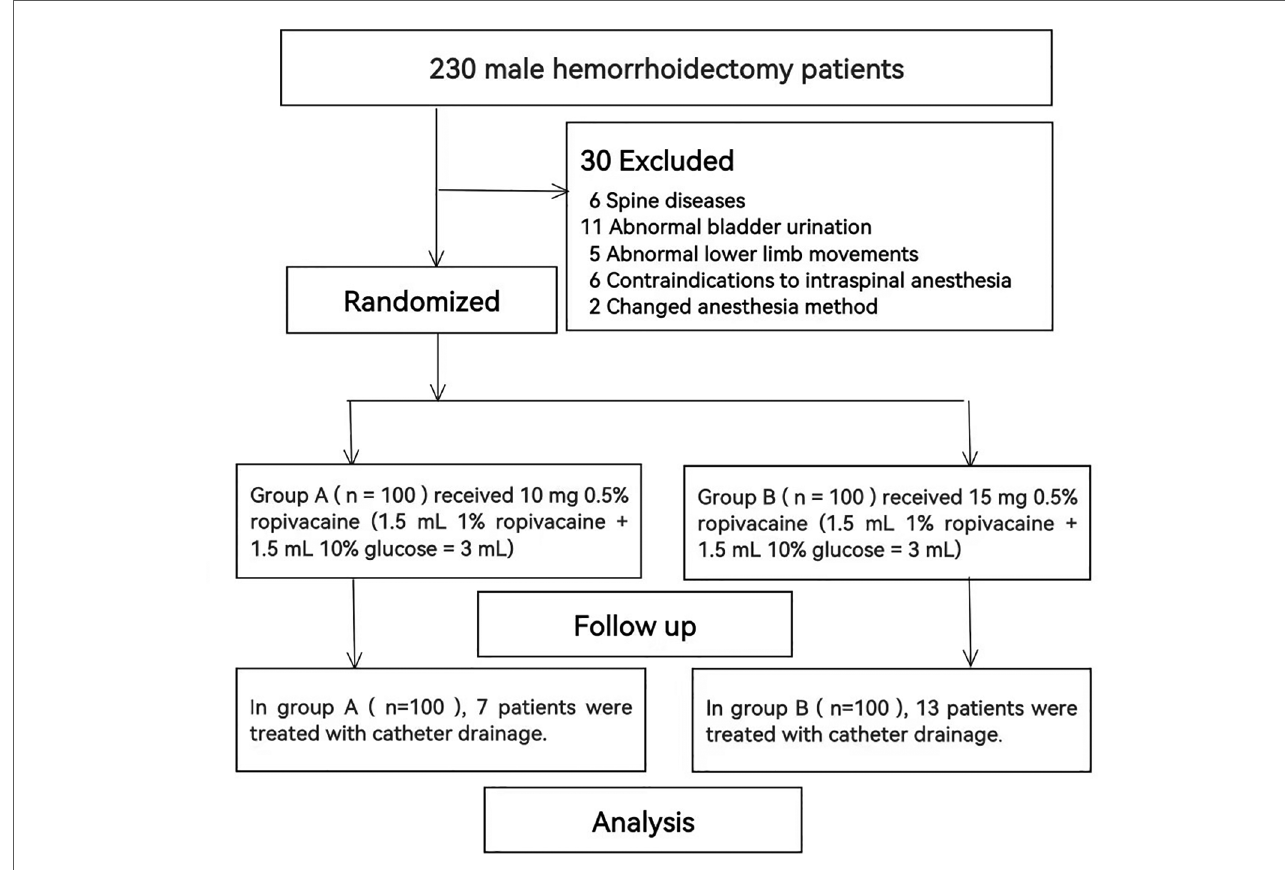
FIGURE 1 Flow of the participants in the